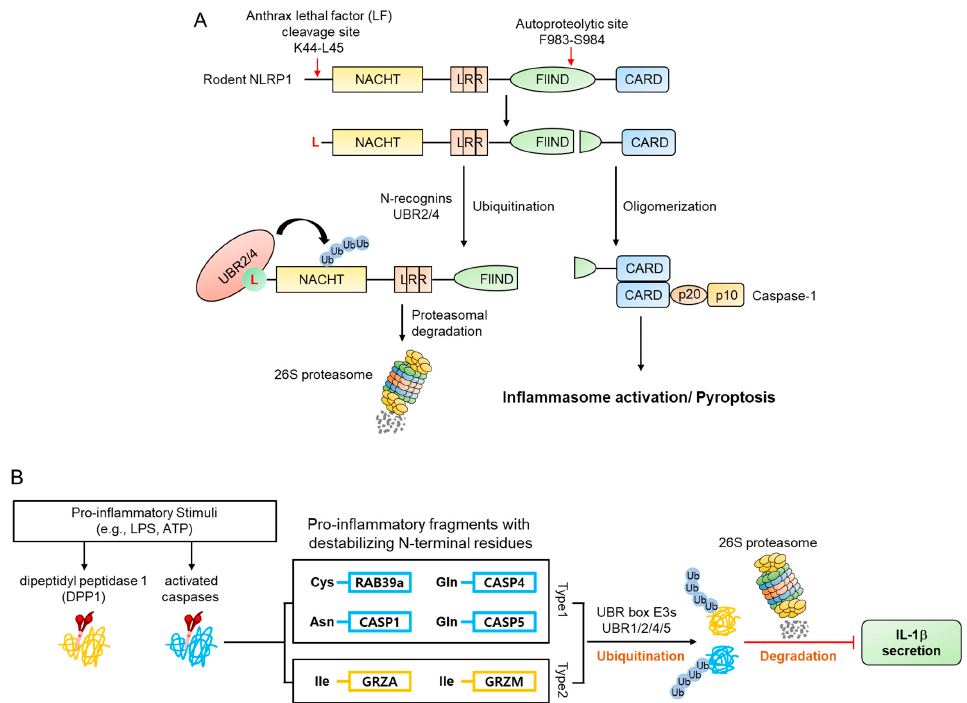
Figure 10. Schematic diagrams describing the regulation of inflammation by UBR box N-recognins. ( A ) A model depicting LT-induced mNLRPB inflammasome activation by UBR2/4. The anthrax lethal factor (LF) is known to induce mNLRP1B